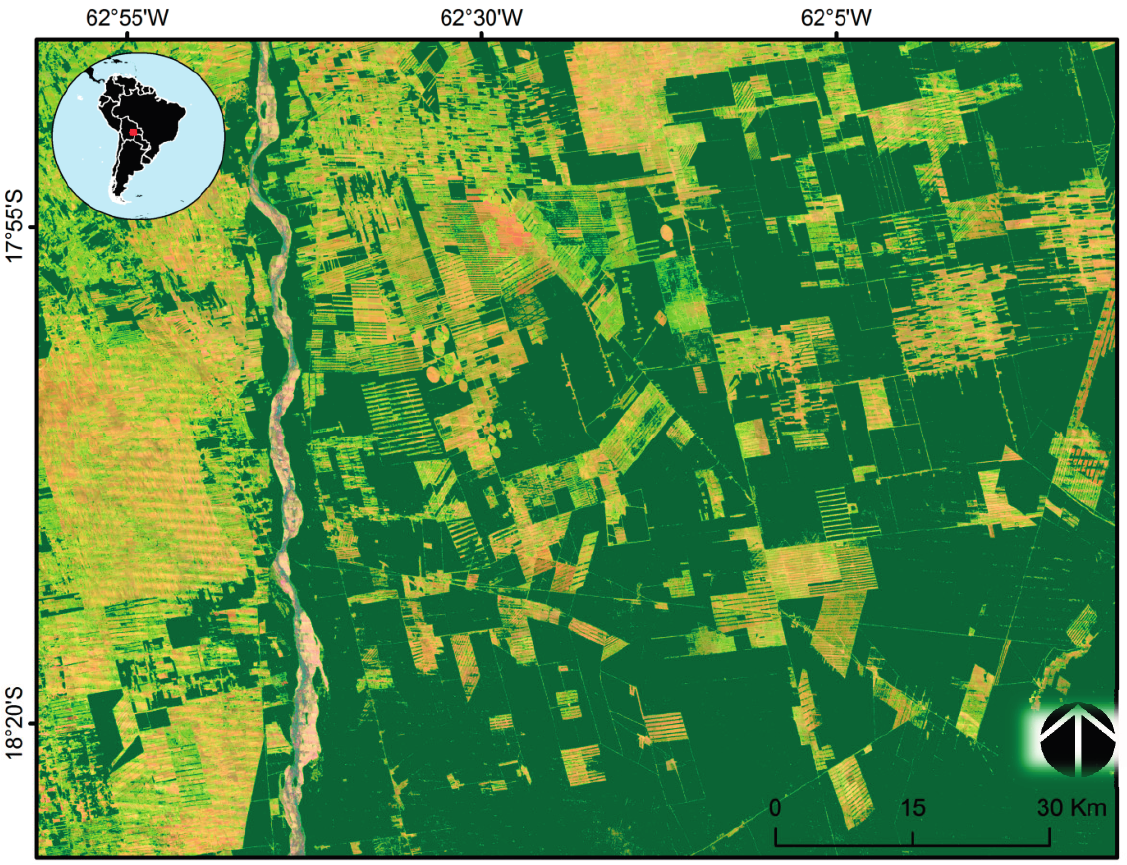
Figure 5. Zoomed in area in Bolivia showing deforestation patterns. Forest (green) is overlaid with the Landsat mosaic. The inset map shows the approximate location of Bolivia.